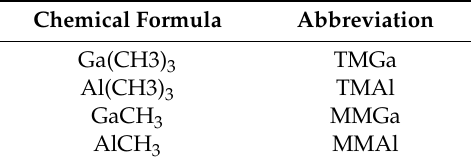
Table 1. Abbreviation of species.